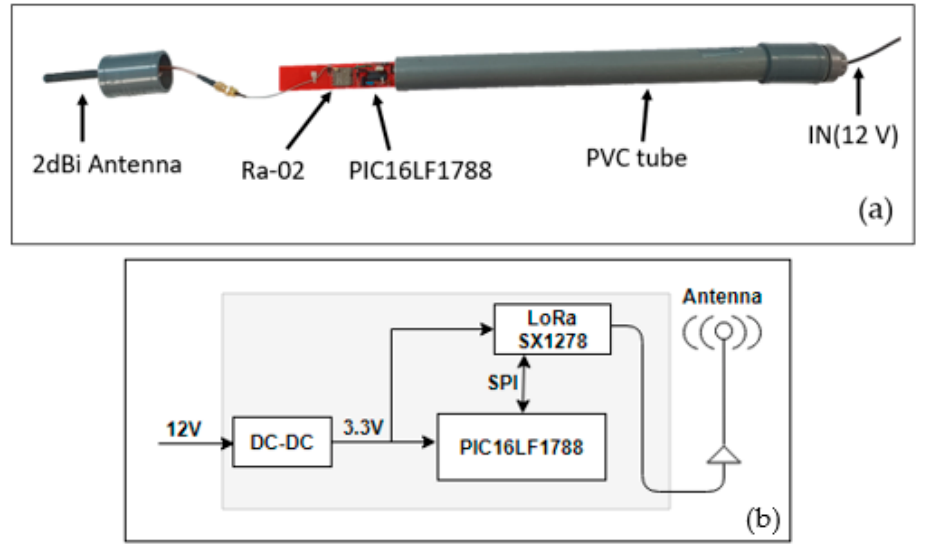
Figure 5. Repeater. Configuration ( a ) and general hardware schema ( b ).